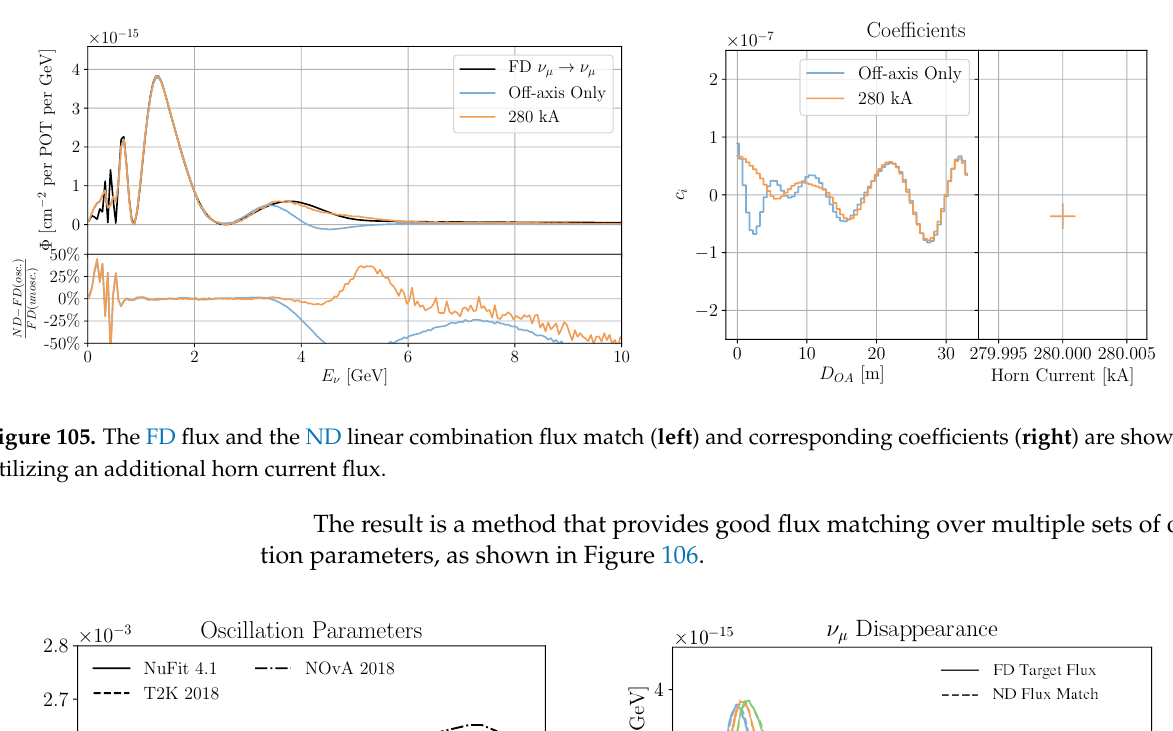
Figure 104. The ratio to the nominal on-axis flux is shown for three off-axis positions, and for on-axis running where the nominal 293kA horn current has been lowered to 280kA. The modified horn current provides an additional constraint just above the first oscillation maximum, with no effect at the lower energies sampled by the off-axis fluxes.